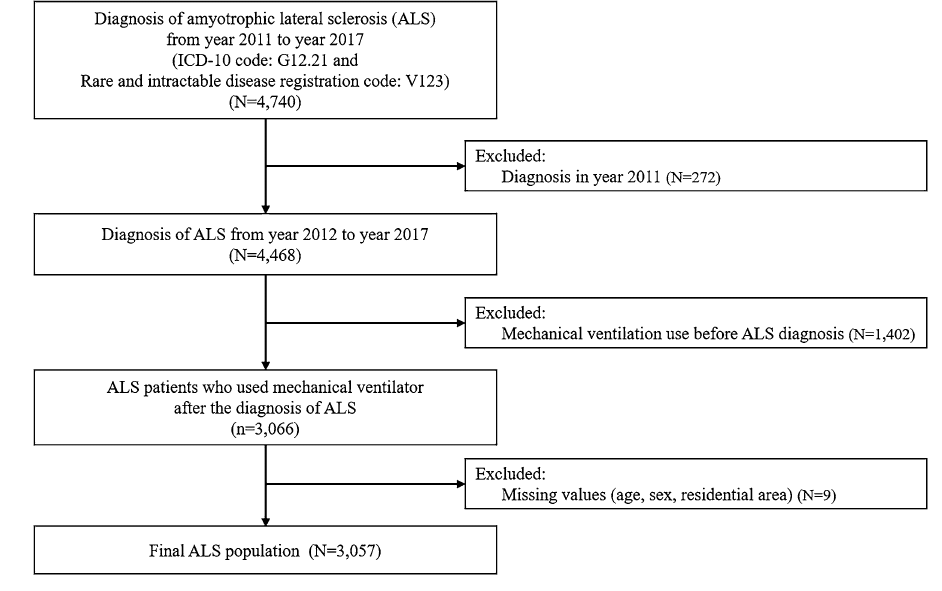
Figure 1. Sample selection